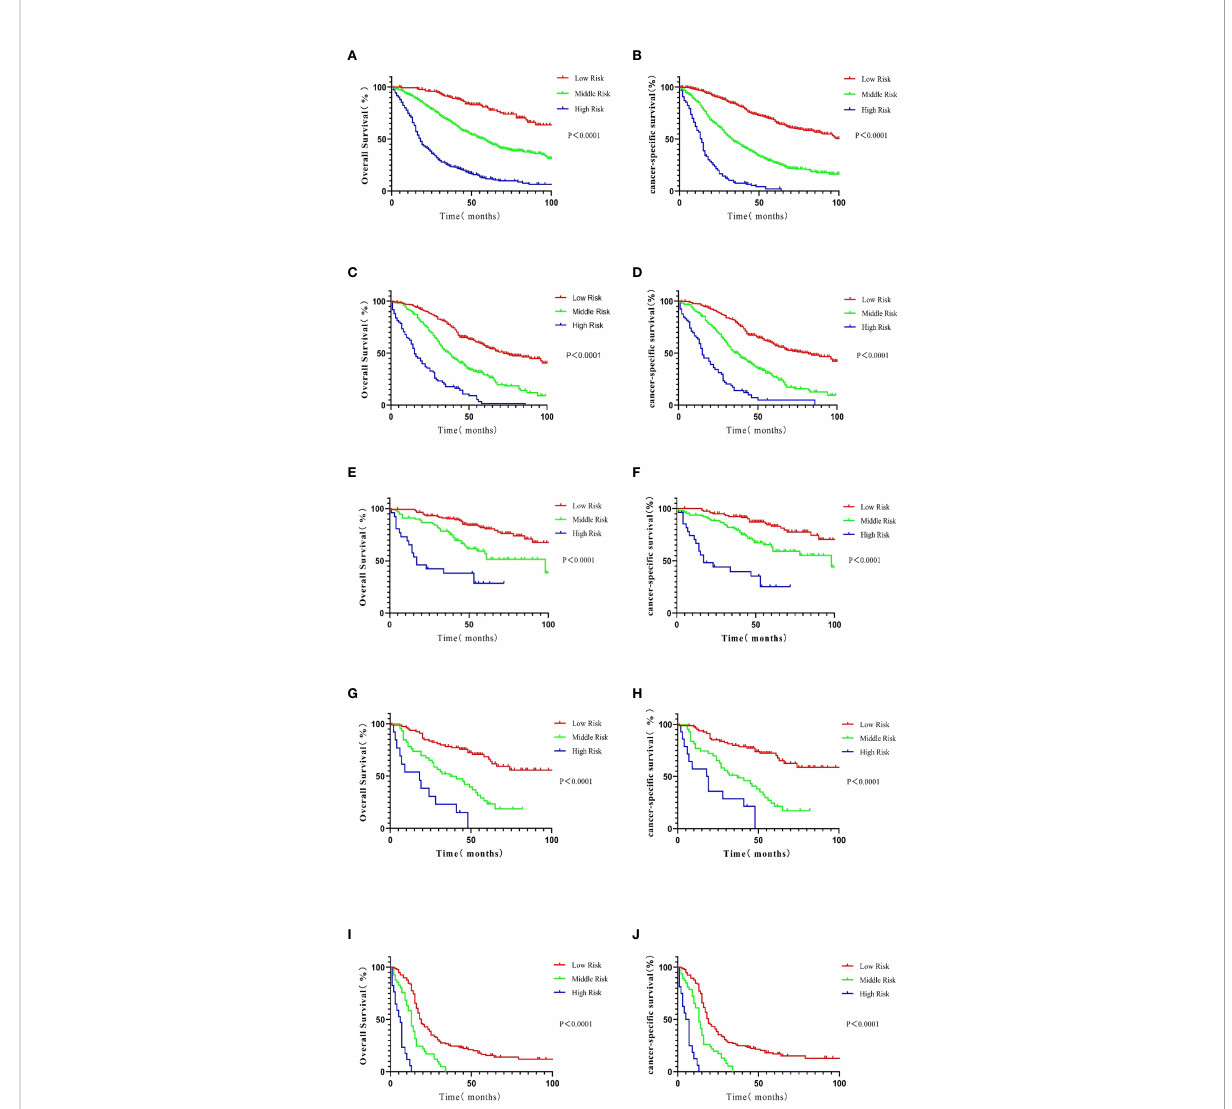
FIGURE 5 Kaplan – Meier analysis of patients in the training cohort. The survival curves were generated from the score calculated by the nomograph for OS (A) and CSS (B) . In patients with luminal A BC, the survival curve was generated from the score calculated by the nomograph: OS (C) and CSS (D) . In patients with the luminal B subtype, the survival curve was generated from the score calculated by the nomograph: OS (E) and CSS (F) . In patients with the HER2-enriched subtype, the survival curve was generated from the score calculated by the nomograph: OS (G) and CSS (H) . In patients with the triple-negative subtype, the survival curve was generated from the score calculated by the nomograph: OS (I) and CSS (J)